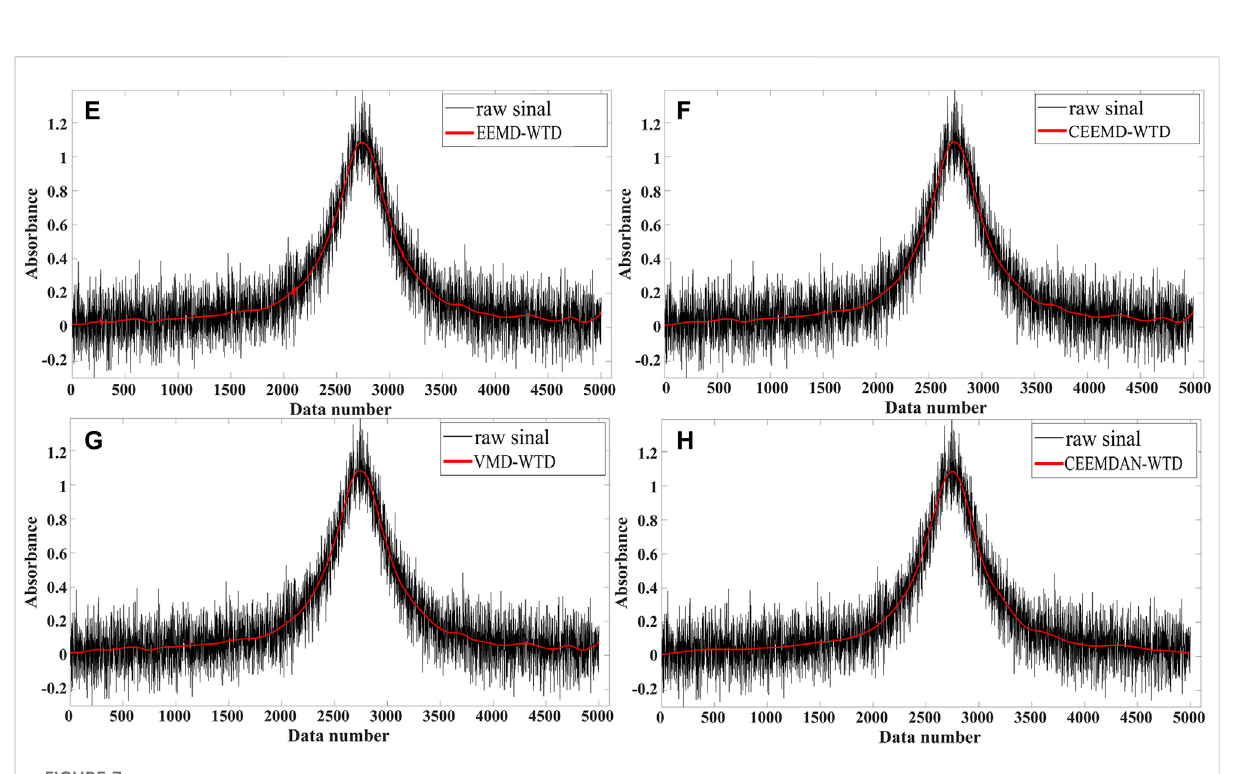
FIGURE 7 Comparison of EEMD-WTD, CEEMD-WTD, VMD-WTD and CEEMDAN-WTD